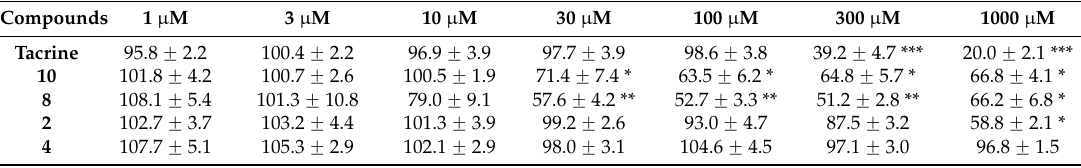
Table 2. In vitro toxicity of imidazopyranotacrines , and tacrine in HepG2 cells. Compounds 1 µ M 3 µ M